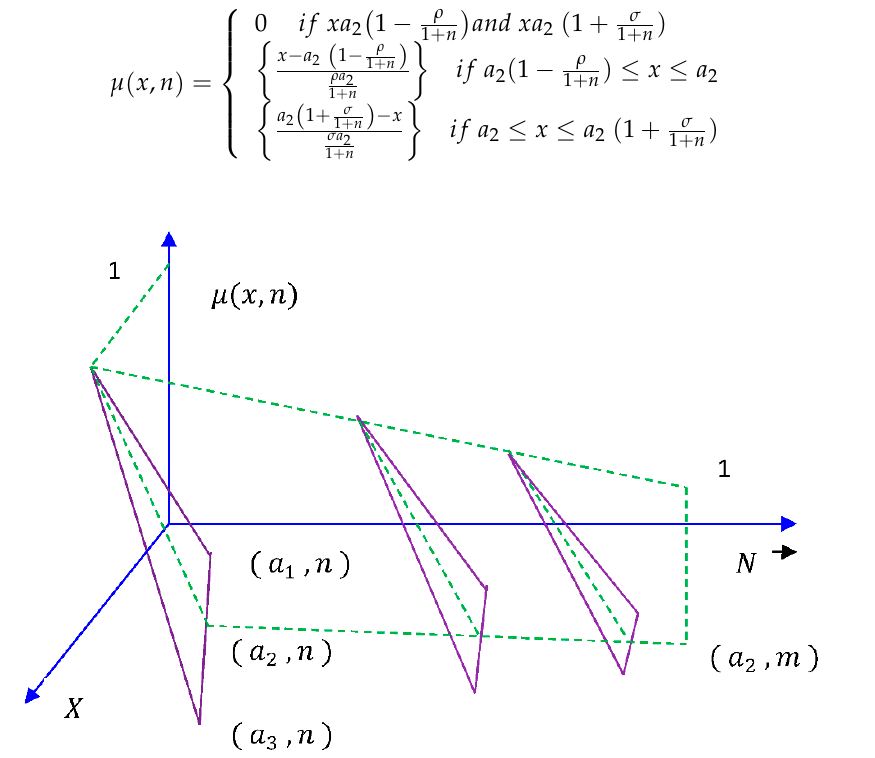
Figure 1. Membership function of normalized triangular dense fuzzy set (NTDFS).